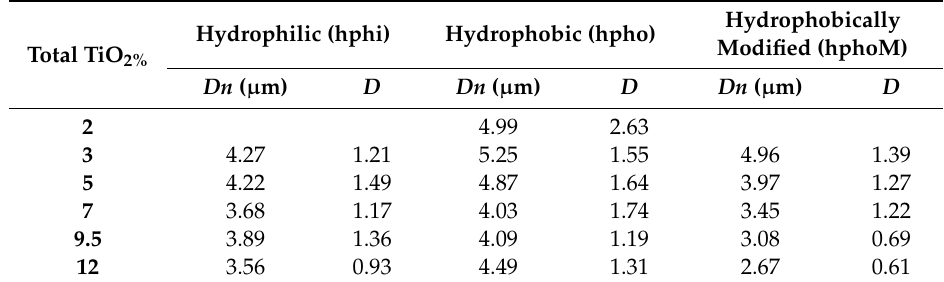
Table 3. Number-average diameter (d n ) and particle size distribution (D) of 80rPP / 20rPET / TiO 2 nanocomposite